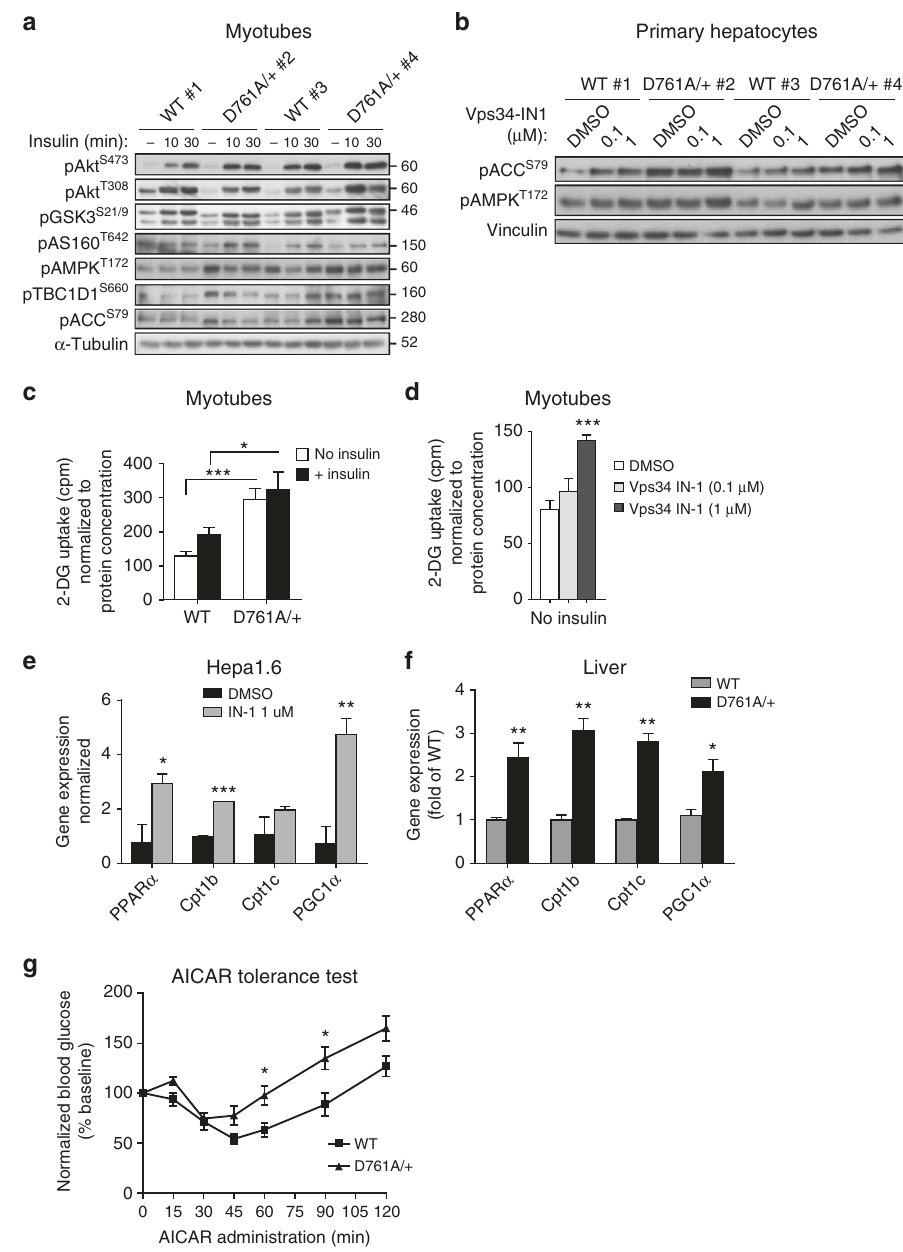
Fig. 9 Impact of Vps34 inactivation on insulin-mediated Akt/mTORC1 and AMPK signaling. a Cultured myotubes were starved for 5 h and stimulated for the indicated time points with 100 nM insulin. Cell lysates were immunoblotted with the indicated antibodies. Representative data from three independent experiments are shown. b Primary hepatocytes were cultured overnight in insulin-free HM in the presence of DMSO or Vps34-IN1 at the indicated doses. Cell lysates were immunoblotted with the indicated antibodies. Representative data of three independent experiments are shown. c 2-Deoxy- D -glucose uptake in differentiated myotubes. Myoblasts were differentiated for 6 – 7 days, starved for 5 h before and stimulated with 100 nM insulin for 20 min. Myotube cultures derived from three independent mice/genotype. Data represent mean ± SEM (Student t -test). d 2-Deoxy- D -glucose uptake in differentiated myotubes. Myoblasts were differentiated for 6 – 7 days, cultured overnight in DMSO or in presence of 1 µ M Vps34-IN1, then starved for 5 h before the assay. Myotube cultures were derived from three independent mice/genotype. Data represent mean ± SEM (Student t -test). e , f Expression levels of genes related to fatty acid β -oxidation in Hepa1.6 cells. e treated overnight in absence or in presence of 1 µ M Vps34-IN1 in serum-free media and in liver tissues f from WT and Vps34 D761A/+ starved mice. Expression levels were quanti fi ed by RT-qPCR from independent cell cultures and from n = 5 mice/genotype. Data represent mean ± SEM (Student t -test). g AICAR tolerance test was performed by intraperitoneal injection of 0.15 g AICAR per kg body weight into overnight-fasted 9 – 11-week-old mice. ≥ 5 – 11 mice/genotype were used. Data represent mean ± SEM (non-parametric Mann – Whitney t - test). * p < 0.05, ** p < 0.01, *** p <